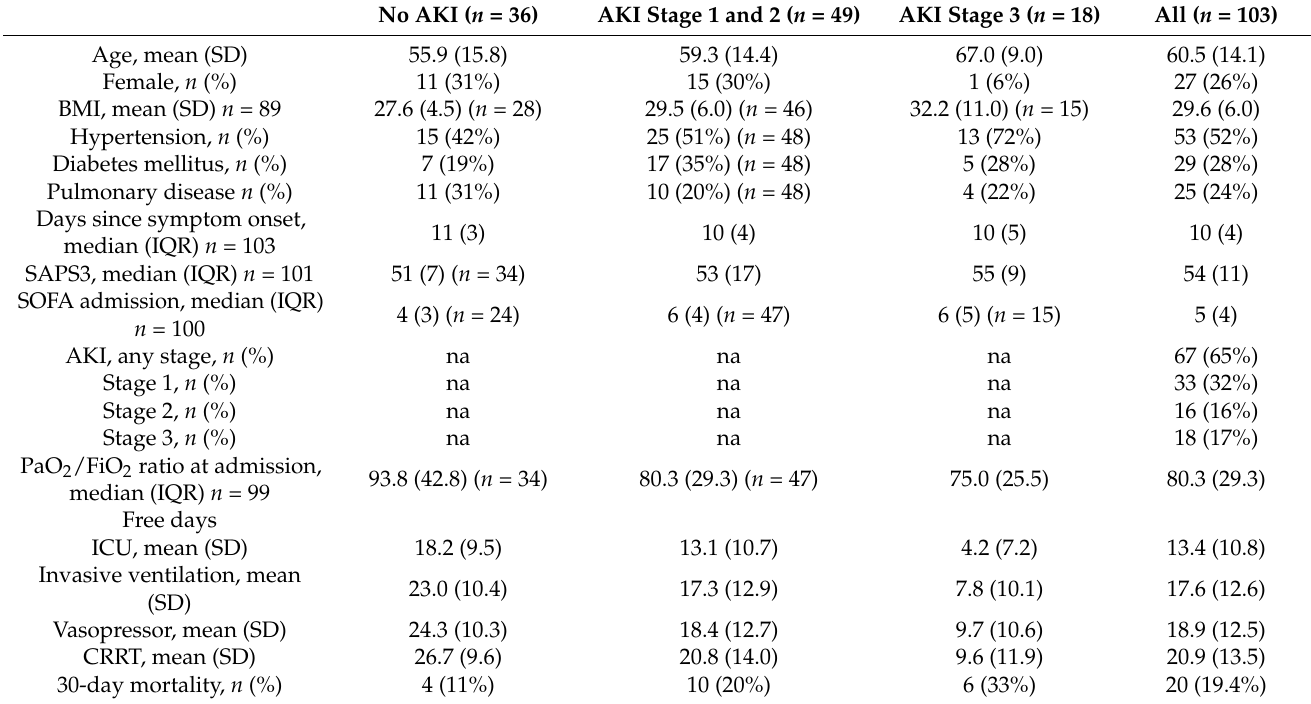
Table 1. Patient